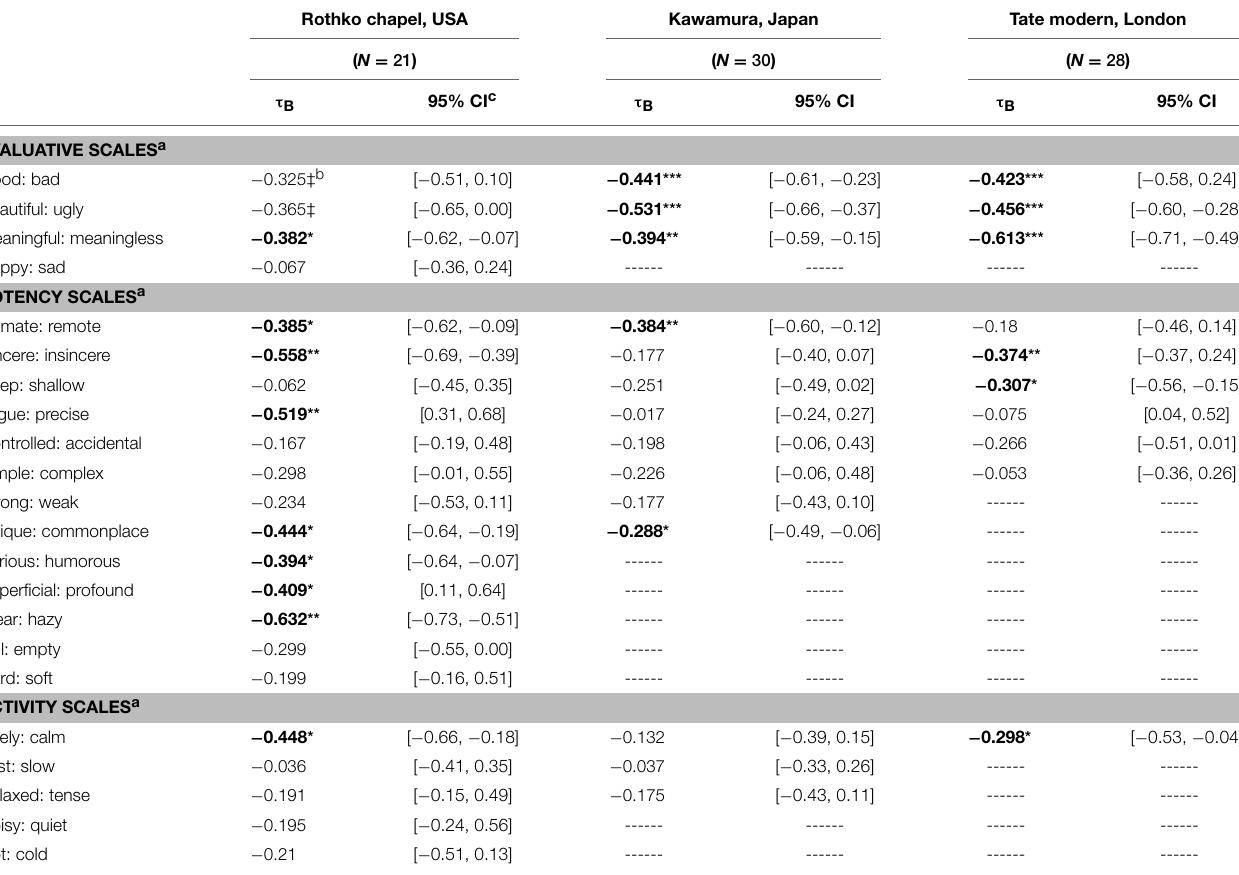
TABLE 3 | Correlation of “feeling like crying” with artwork evaluation in three encounters with museum art.